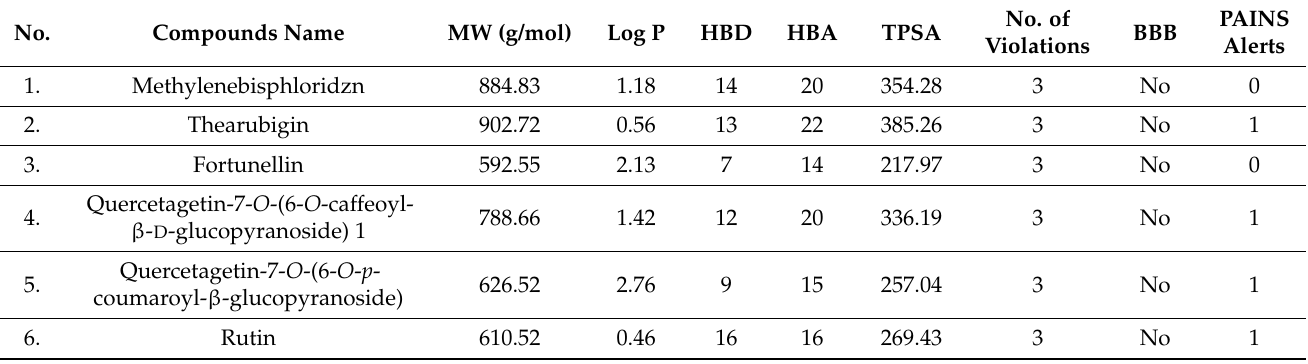
Table 2. Physicochemical properties of flavonoid molecules calculated by SwissADME web